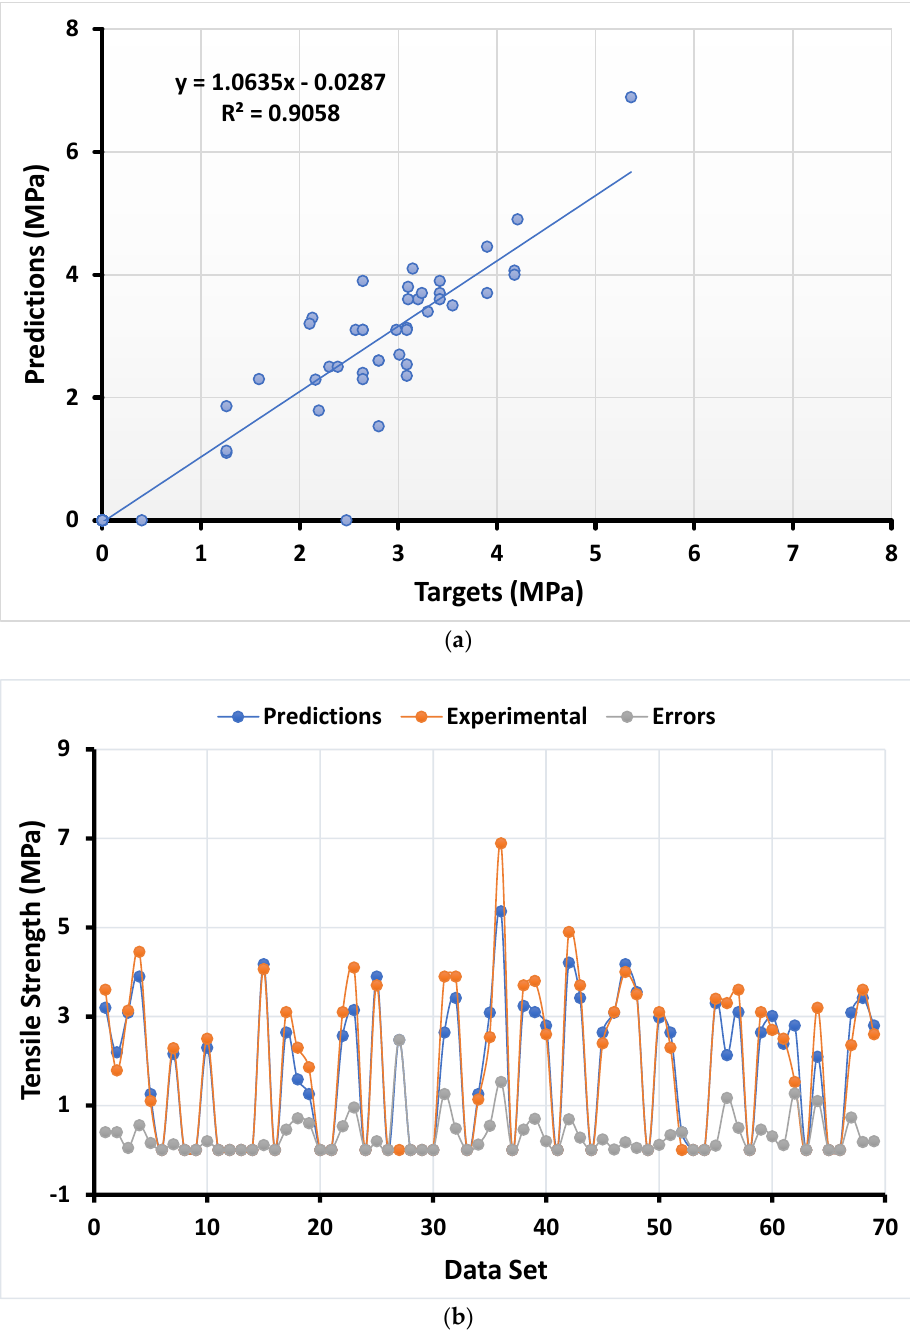
Figure 4. Numerical analyses representing the relationship between the predicted variables and targeted variables ( a ) along with their error distribution ( b ) for splitting tensile strength using DT.